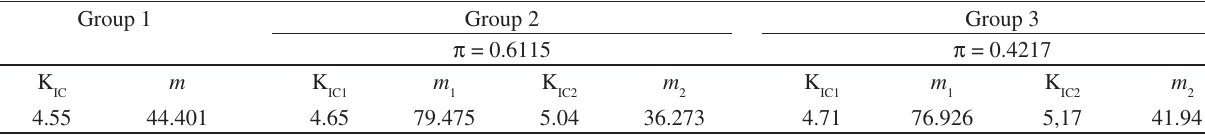
Table 2. K and apparent Weibull modulus ( m ) of indentation strength tests ( IS ) for the different groups. IC